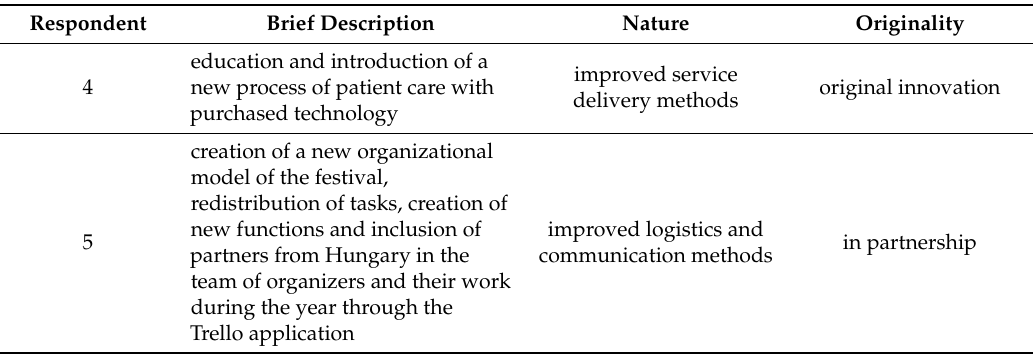
Table 8. An overview of process innovations in the